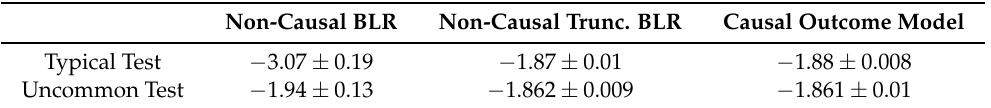
Table 5. Average Predictive Log Likelihood and standard deviation for non-causal Vanilla Bayesian Linear Regression, non-Causal Truncated Bayesian Linear Regression and causal Outcome Model on a typical test set and on a test set of uncommon subjects (German native speakers).